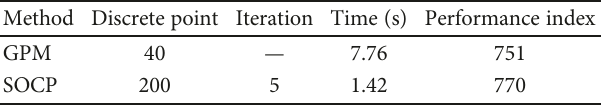
Figure 7: The penetrator ’ s fuel consumption rate pro fi les, using the two methods. Table 3: Comparison of the time consumed with performance indexes, using the SOCP and GPM methods.